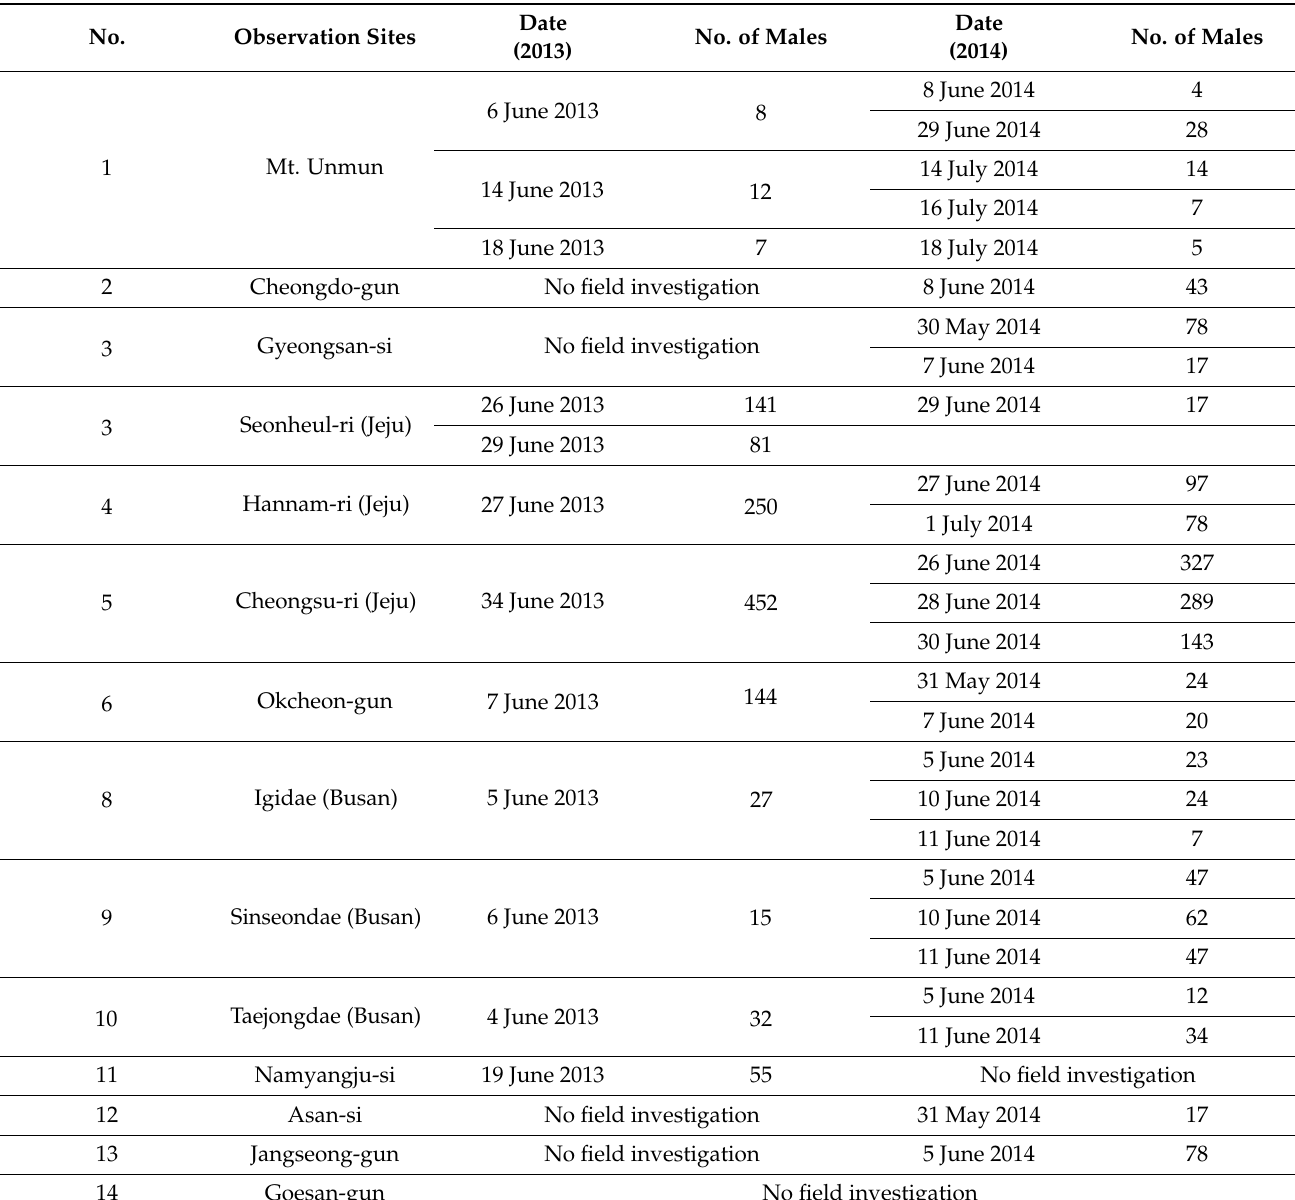
Table 3. Census results of L. unmunsana in South